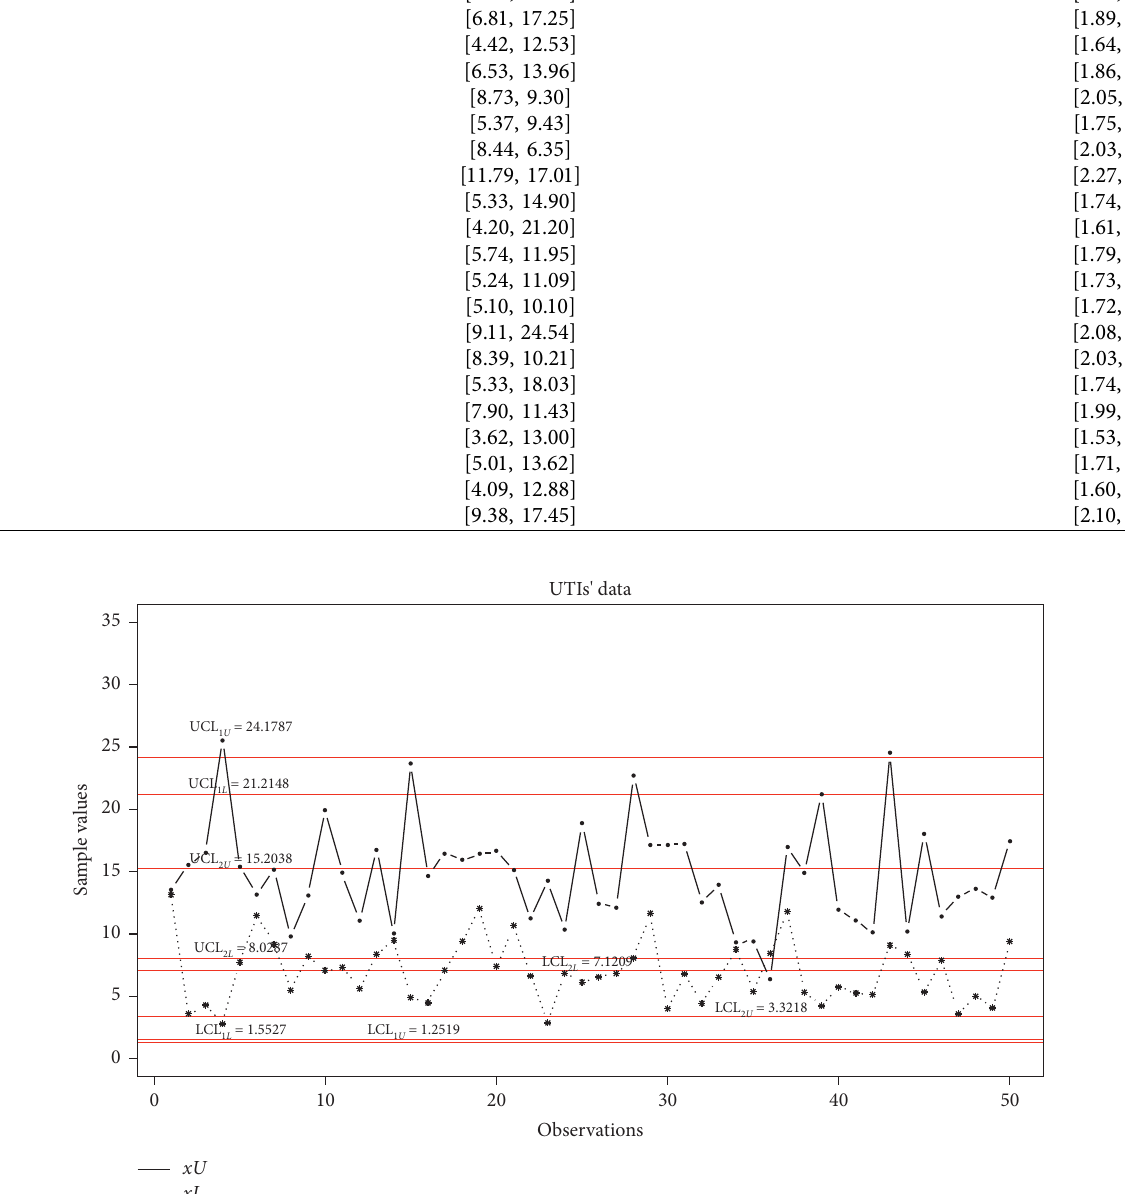
Figure 3: The proposed control chart for UTIs’